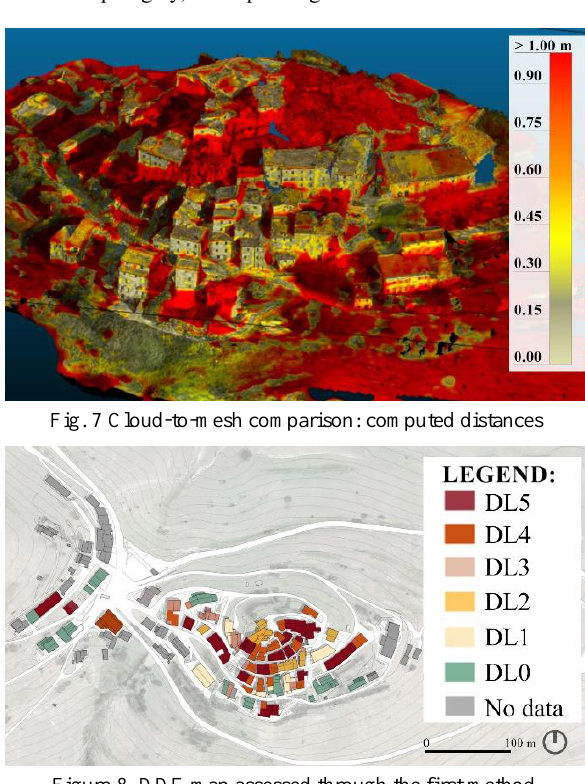
Figure 8. DDE map assessed through the first method.